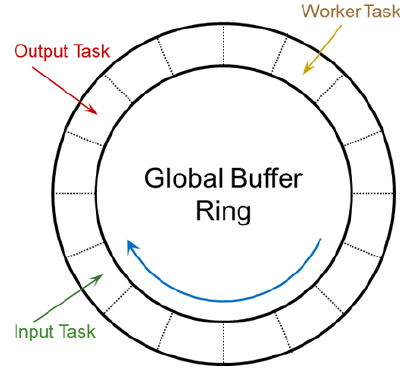
Fig. 2. The global buffer ring in Fig. 1. The schematic diagram of MT-SNiPER.